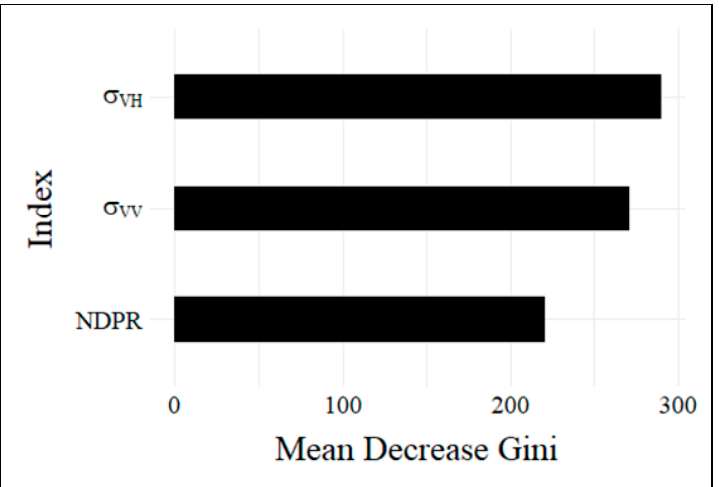
Figure 8. Importance evaluation of the input variables of the random forest algorithm used for pre- dicting PWN infestation from Sentinel-1 image.